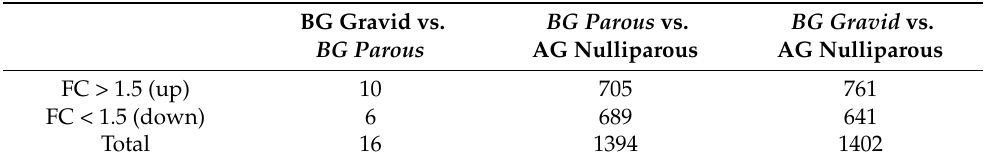
Figure 3. Differential gene expression (DGE) of 12,710 genes in the heads of below-ground Culex pipiens (BG1) and above-ground Cx. pipiens (AG2). Panel ( A ) shows DGE in a contrast between gravid and parous BG1 females. Panel ( B ) shows the contrast between parous BG1 and nulliparous AG2 females, both ready to engage in host-seeking behavior. Each point represents differential expression of a single gene, where grey points indicate no significant differences in expression, green points show log 2 fold-change values that are not statistically significant, blue points represent genes with statistically significant differences in expression but low log 2 fold-change values, and red points represent genes with a >1.5-fold difference between treatments where this difference was statistically significant. Table 2. Numbers of differentially expressed genes that reach our fold change ( ± 1.5) and statistical significance thresholds ( α = 0.05) after a Benjamini and Hochberg adjustment for false discovery rate. The reference for each treatment contrast is